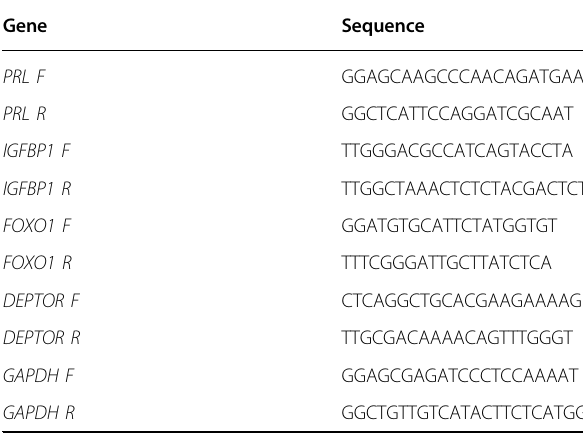
Statistical analysis All data are presented as the mean ± standard deviation (SD). Where necessary, statistical signi fi cance was deter- mined by performing a one-sample t -test. P -values of < 0.05 were considered statistically signi fi